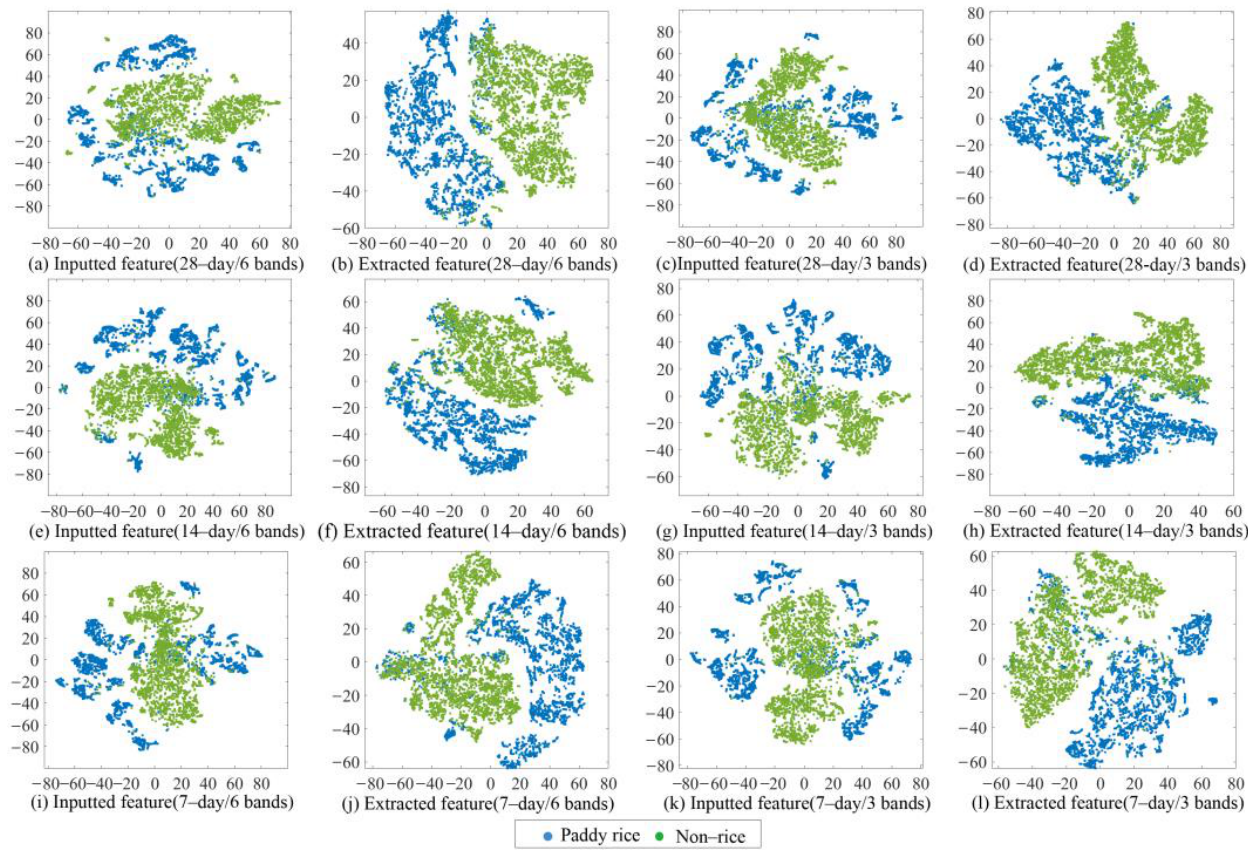
Figure 8. Visualization of inputted features and extracted features by model with different time intervals and band combinations. The 3-band combination includes red band, near-infrared band, and Swir-1 band. The 6-band combination includes red, green, blue, near-infrared, and two Swir bands.